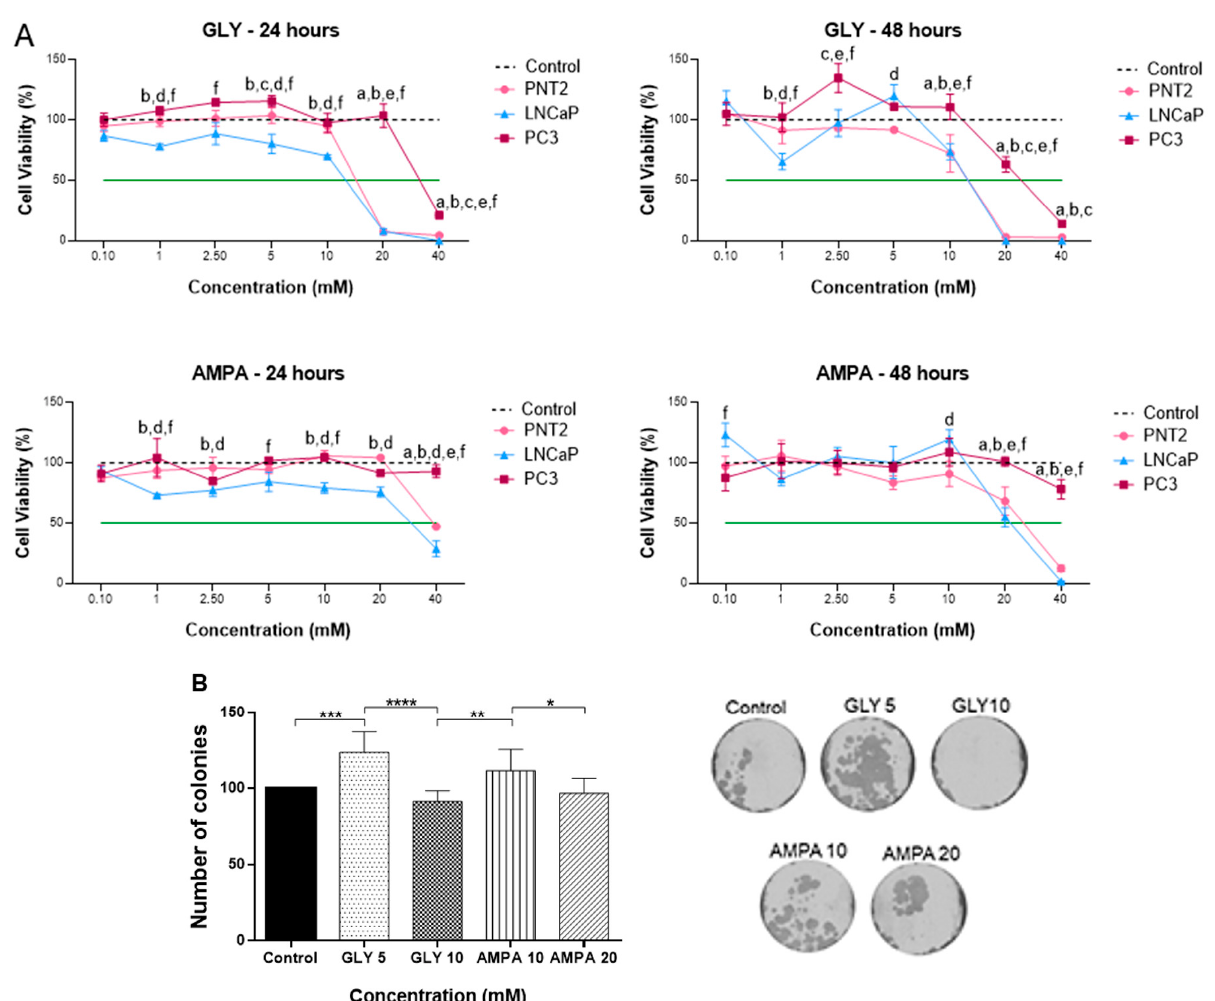
Figure 1. Effects of glyphosate (GLY) and aminomethylphosphonic acid (AMPA) on the viability and proliferation of prostate cell lines. ( A ) MTT assay was conducted for 24 and 48 h on PNT2 (non-tumorigenic), LNCaP (hormone-dependent tumorigenic), and PC-3 (hormone-independent tumorigenic) cell lines treated with GLY and AMPA. Lowercase letters over graph lines represent significant differences between cell lines: (a) PNT2 × Control (untreated cells), (b) LNCaP × Control, (c) PC-3 × Control, (d) PNT2 × LNCaP, (e) PNT2 × PC-3, (f) LNCaP × PC-3. The green-dashed line corresponds to 50% cell viability. ( B ) The colony formation assay was performed to evaluate the effect of GLY and AMPA on PNT2 cell proliferation (crystal violet staining). * p < 0.05, ** p < 0.01, *** p < 0.001, **** p < 0.0001. Results ( A , B ) are expressed as means ± standard deviation of three independent tests performed in triplicate.